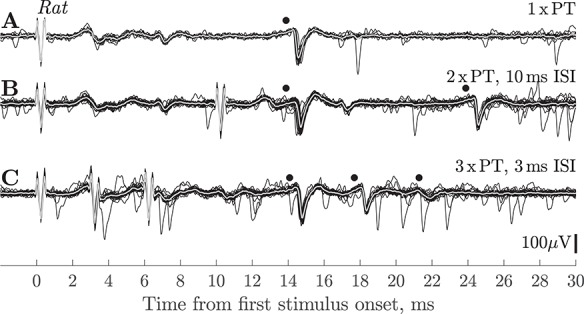
Rat. Antidromic responses of slow PTN in motor cortex. (A) Single PT shock (90 μA) evoked a response from a slow PTN (•) at 14.6 ms. (B) Responses to 2 × PT (90 μA) shocks with an ISI of 10 ms; the PTN showed antidromic responses to both shocks (•), the amplitude of the second spike was reduced. (C) Responses to 3 × PT (90 uA) shocks with an ISI of 3 ms; responses (•) were present to all three shocks, but with a marked decrease in spike amplitude. Isoflurane anesthesia was on for A–C. The reduction in amplitude with successive shocks was not seen in all rat PTNs, and it is unlikely that it was related to any failure in antidromic invasion, but rather was caused by changes in the spike generation mechanism when the PTNs were activated at high frequency. It is noticeable that the attenuation was less for the ISI 10 ms stimuli (B) than for ISI 3 ms (C).